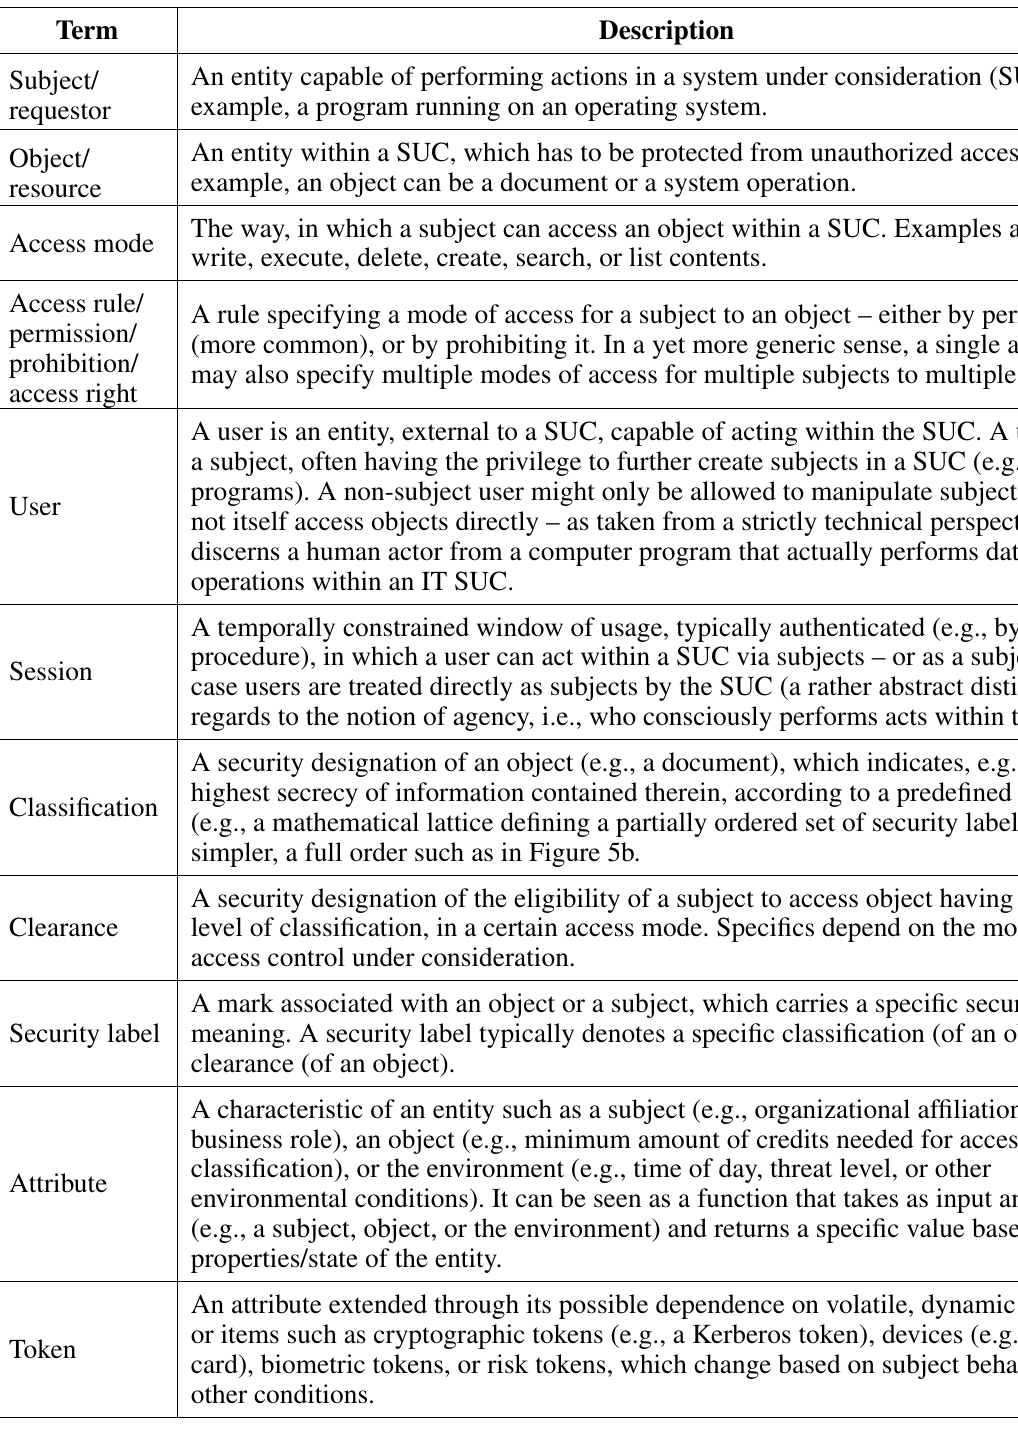
Table 2. Common vocabulary of access